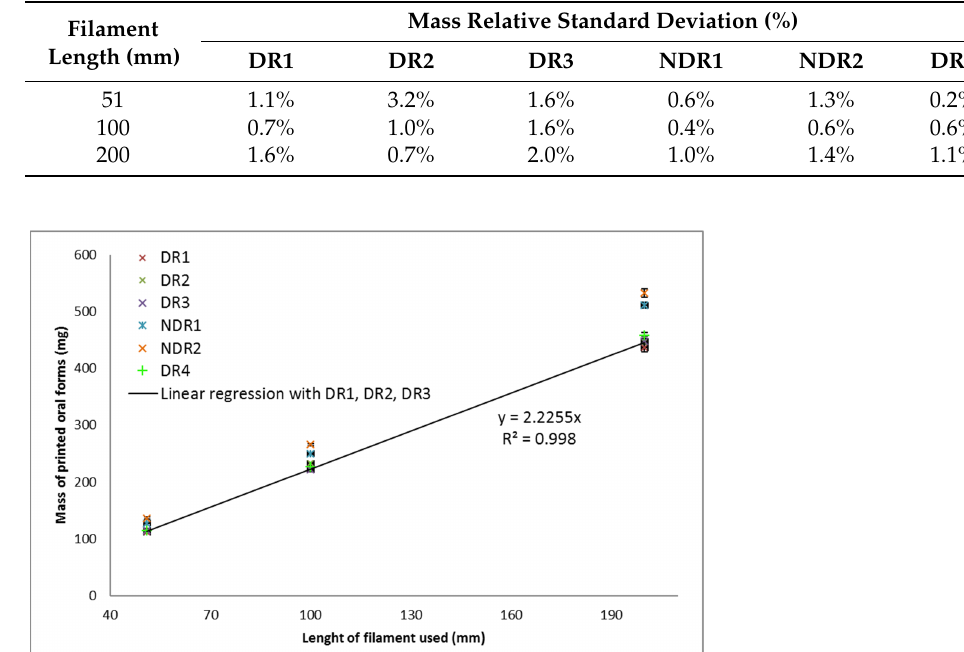
Table 12. Mass relative standard deviation of batches according to the printed filament length.